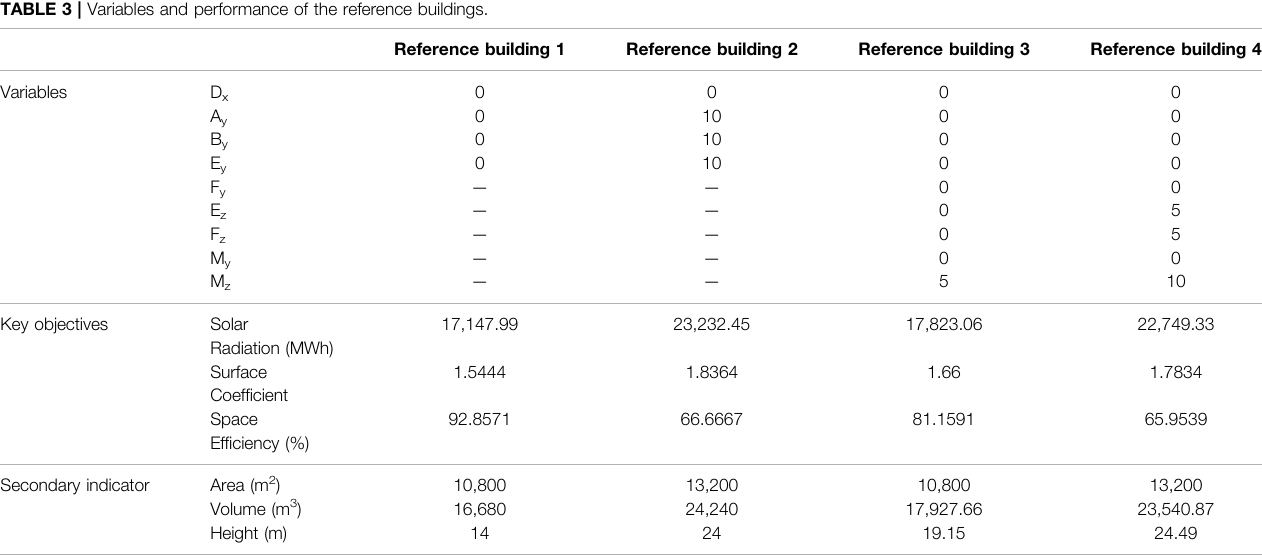
TABLE 3 | Variables and performance of the reference